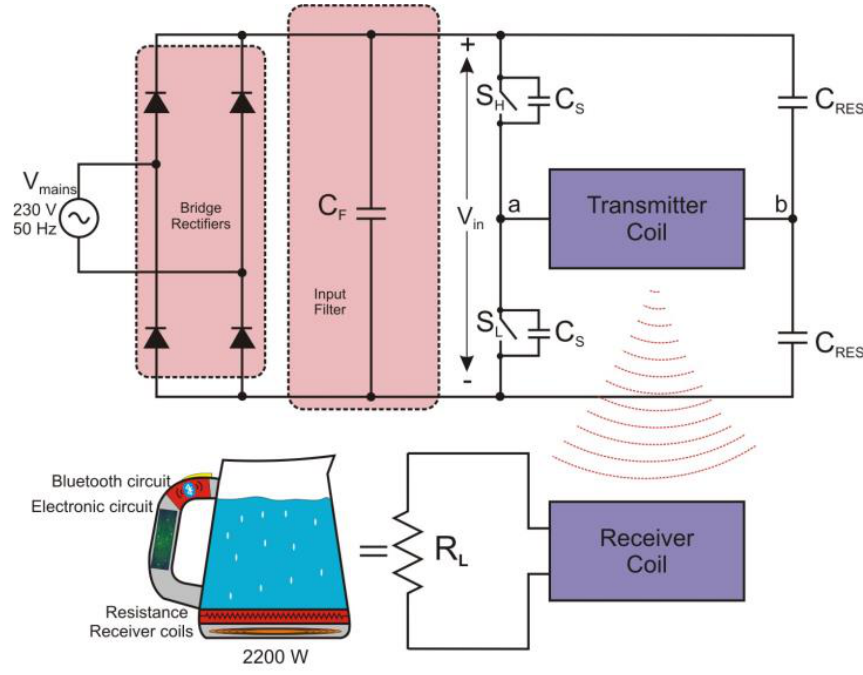
Figure 4. HB series resonant circuit in IPT system.